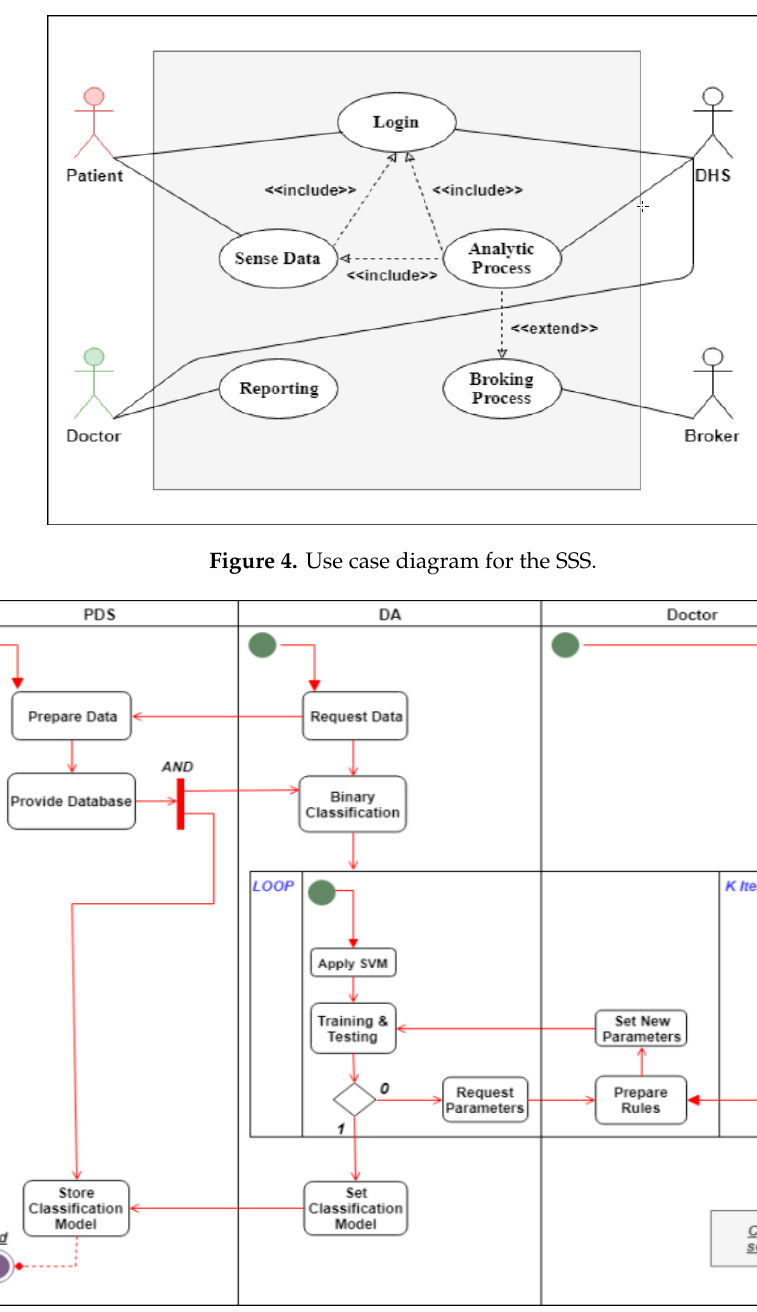
Figure 5. Activity diagram for the analytical process use case (SSS) .